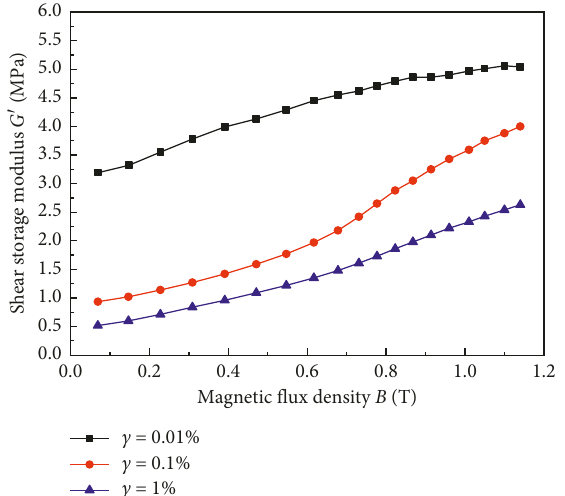
Figure 3: Variation of shear storage modulus with magnetic flux density for MRE at different strains.